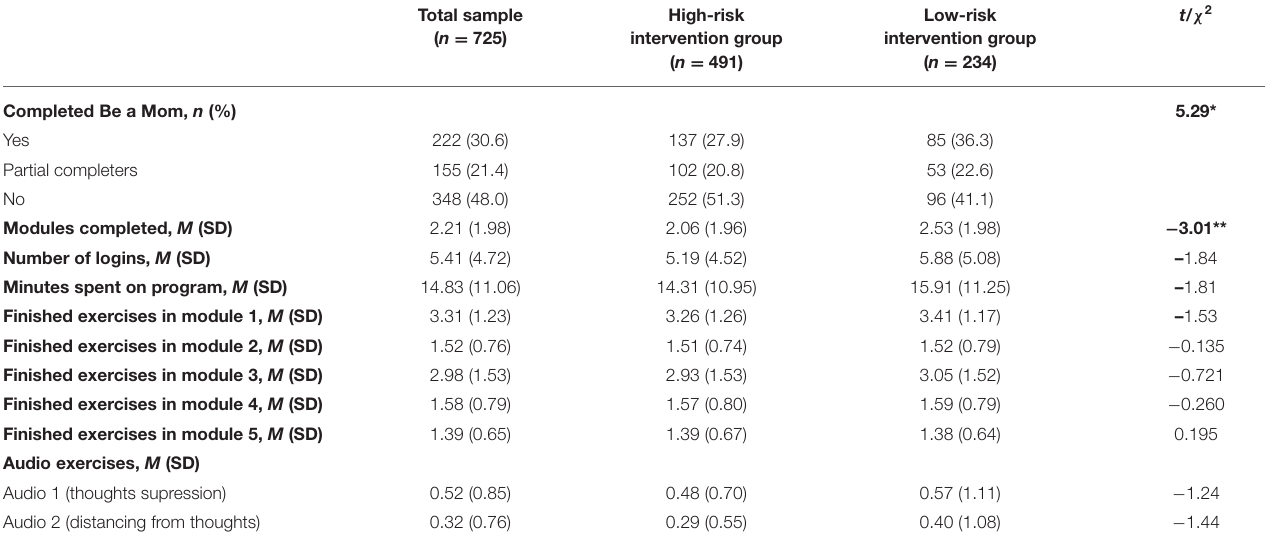
TABLE 2 | Participants’ patterns of program